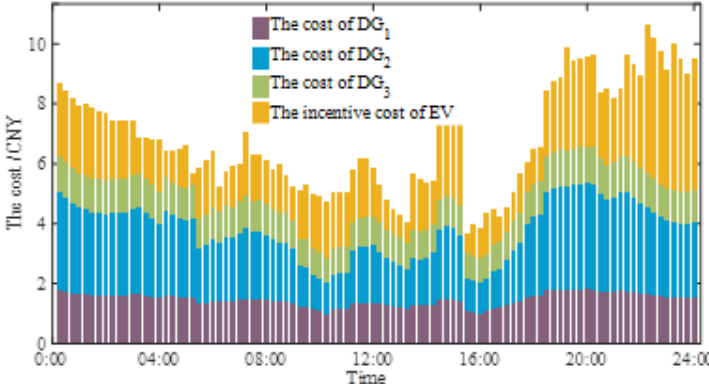
Figure 6. The results of the first stage optimization.